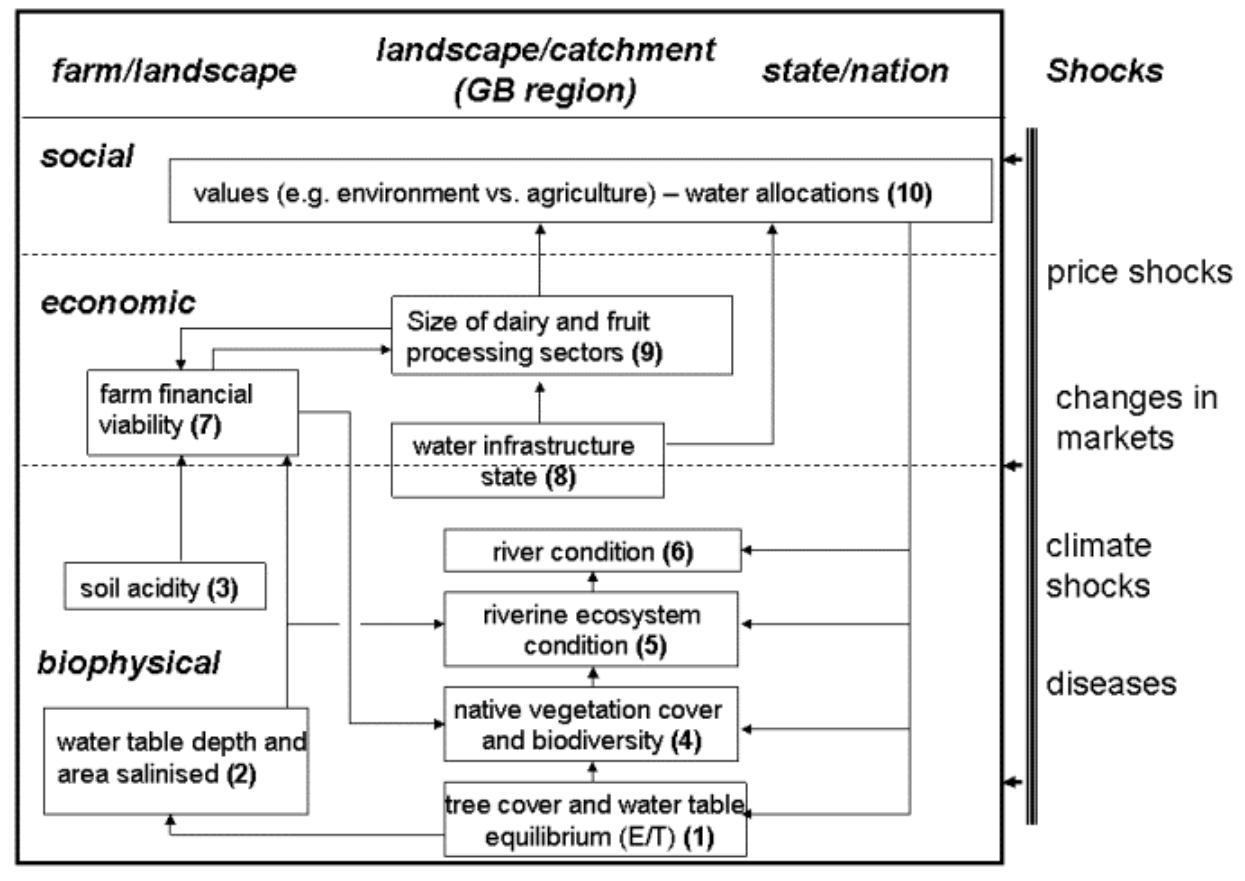
Fig. 6. Ten slow variables with identified thresholds in the panarchy that constitutes the Goulburn- Broken Region. The arrows between boxes indicate possible cascading threshold